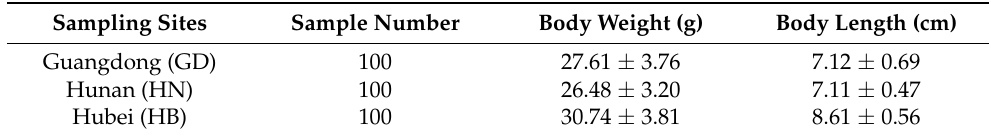
Table 2. Basic weight and lengths of P. clarkii sampled from different